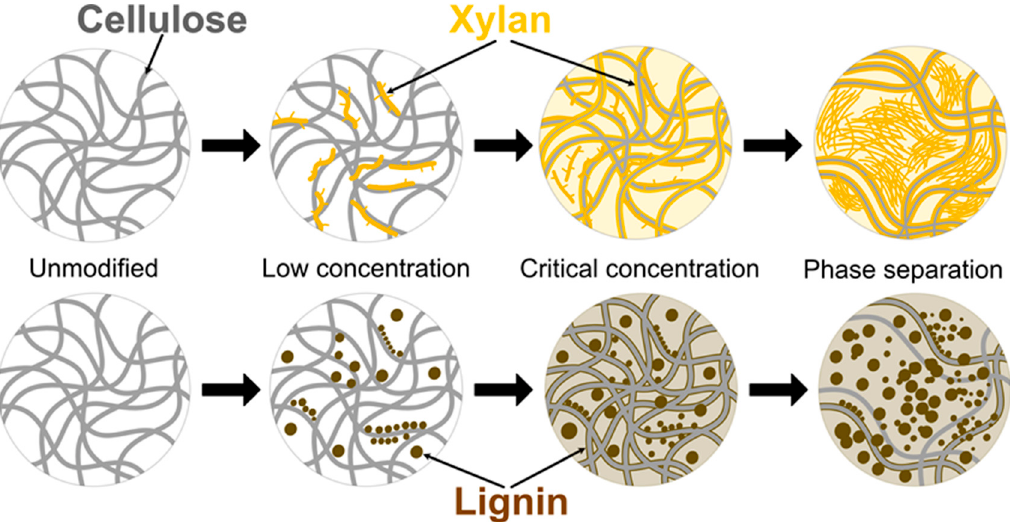
Figure 1. Schematic representation of the nanopapers structure.